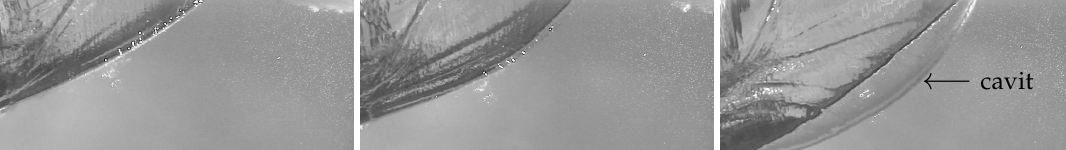
Figure 13. Evolution of the water entry of a wedge (V) ( β = 20 ◦ ) entering the water at 53.3 , and 66.6 ms from the impact. The arrow highlights the cylindrical front of the cavitating area.